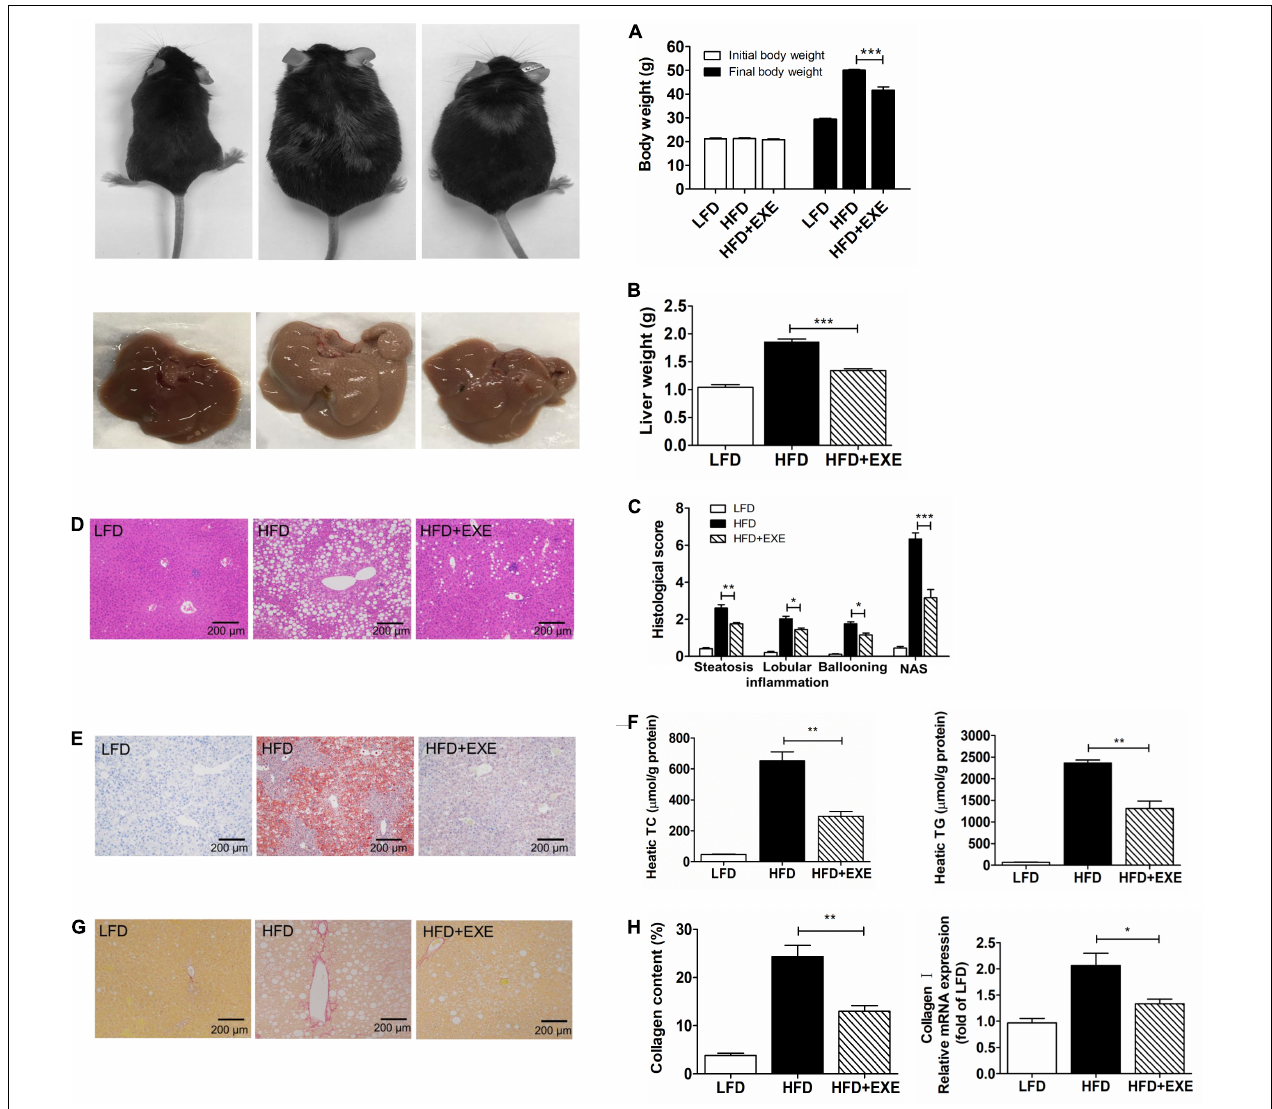
FIGURE 1 | Exercise reduced HFD-induced body weight, liver weight, hepatic steatosis, inflammation, and fibrosis. The body weight (A) and liver weight (B) decreased after 12 weeks of exercise training. Liver sections stained with H&E ( × 100) (C) . Hepatic histological analysis of steatosis, inflammation, ballooning, and NAFLD activity score (NAS) (D) . Hepatic lipid accumulation as determined by Oil Red O staining ( × 100) (E) . Hepatic TC levels and TG levels (F) . Liver sections stained with Sirius Red ( × 100) (G) . Collagen content determined by counting Sirius Red positive areas in six randomly selected fields using Image Pro Plus 6.0 software and hepatic mRNA levels of Collagen I (H) . Results are presented as the mean ± SEM, n = 6–8 per group. * P < 0.05, ** P < 0.01, and *** P <